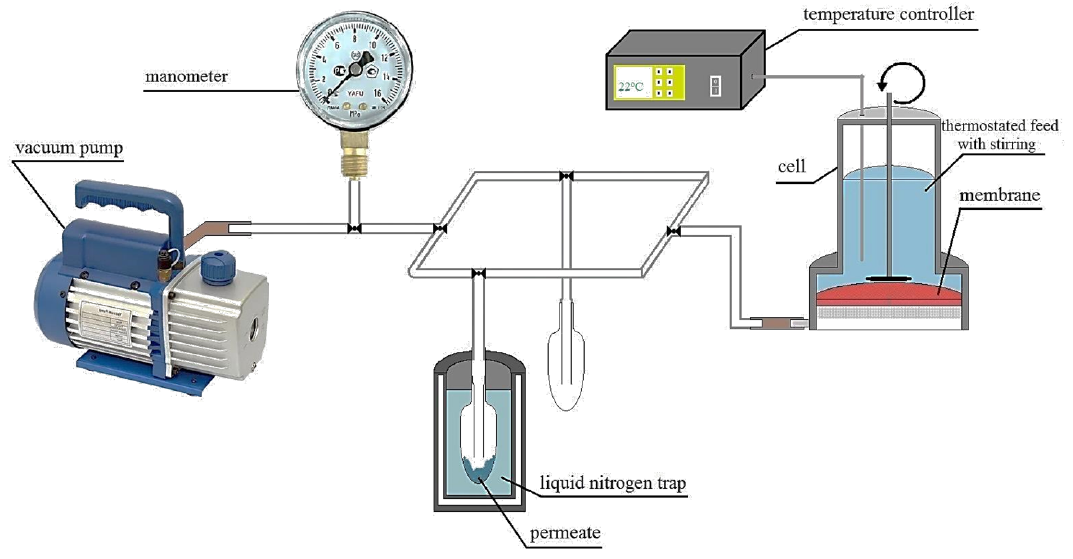
Figure 2. The scheme of the pervaporation setup.